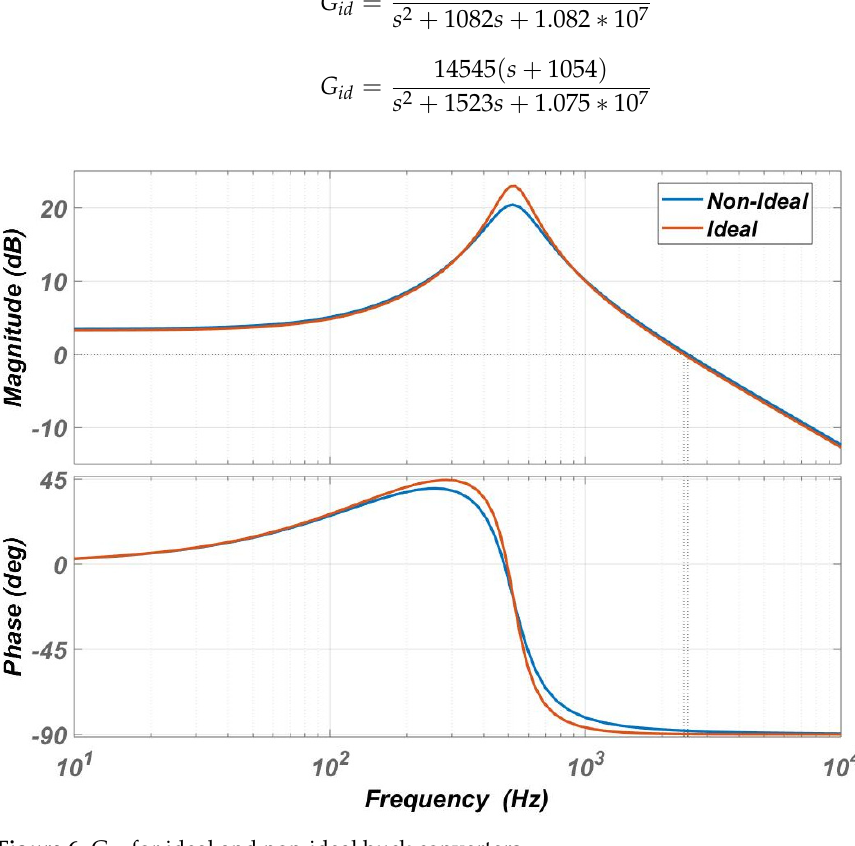
Figure 6. G id for ideal and non-ideal buck converters.